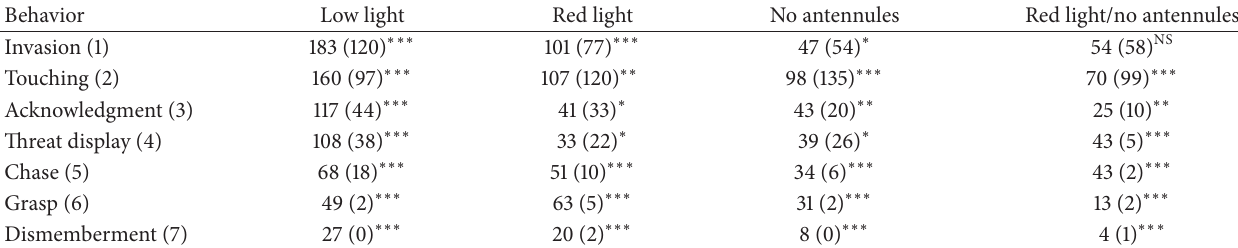
Table 3: Total number of social interaction across study conditions for sighted crayfish. Social interactions were observed for both “in water” and “out of water.” Each row corresponds to the total number of interactions for a given behavioral score. Each column corresponds to an environmental condition. In this and succeeding tables, the numbers in brackets are the total “out of water” interactions. Behavior Low light Red light